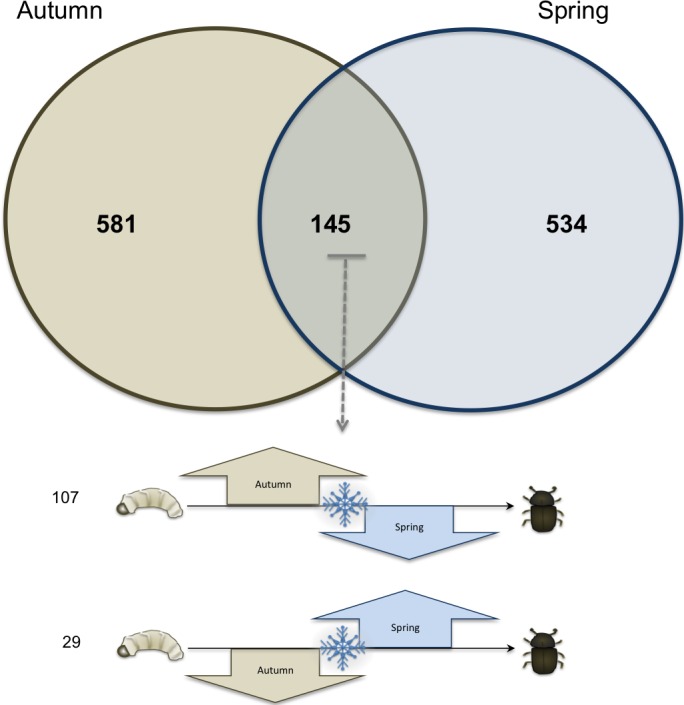
Venn diagram of total transcriptome.Venn diagram showing the number of significantly changing transcripts unique to autumn (brown circle), and unique to spring (blue circle), and those that showed significantly shifts in both autumn and spring (middle). Of the 145 gene transcripts that showed a significant difference in both autumn and spring, 107 increased in autumn and decreased in spring, and 29 are decreased in autumn and then increased in spring.